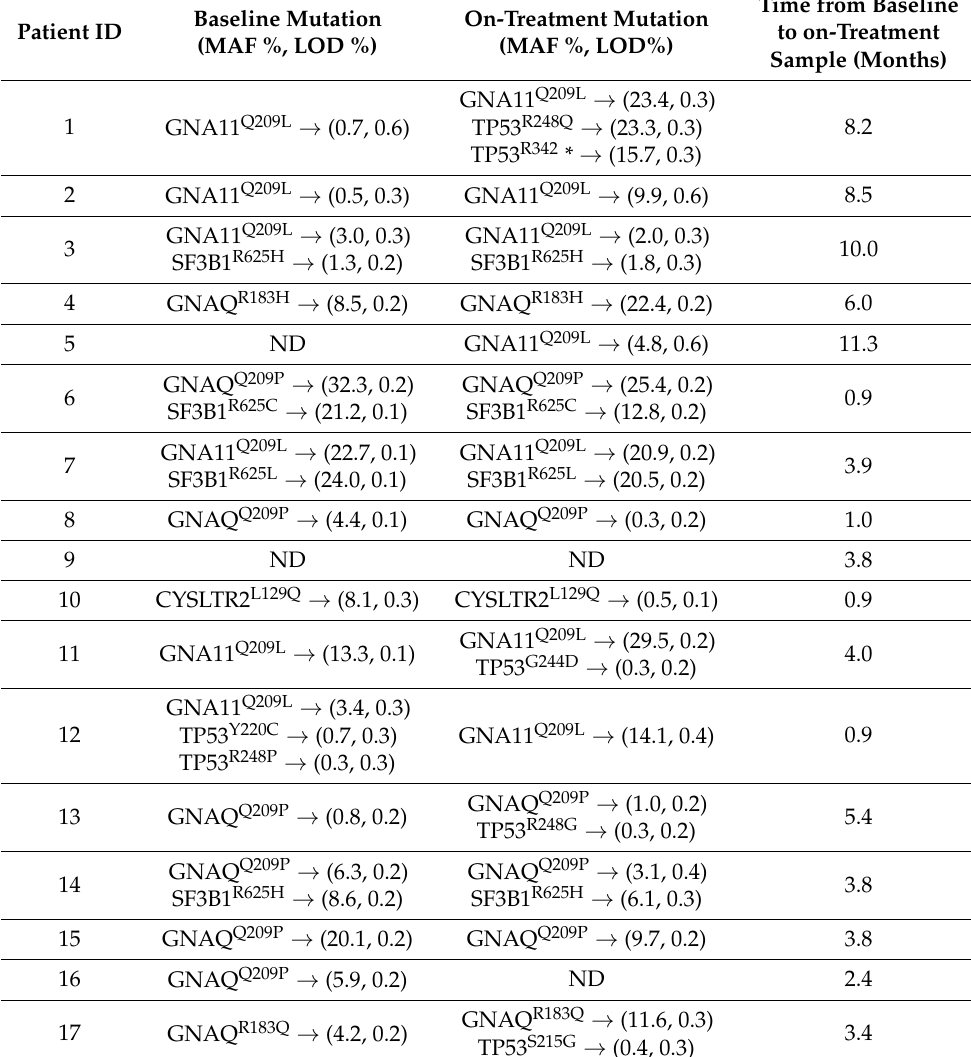
Table 2. Liquid biopsy mutation analysis using Ion Torrent next generation